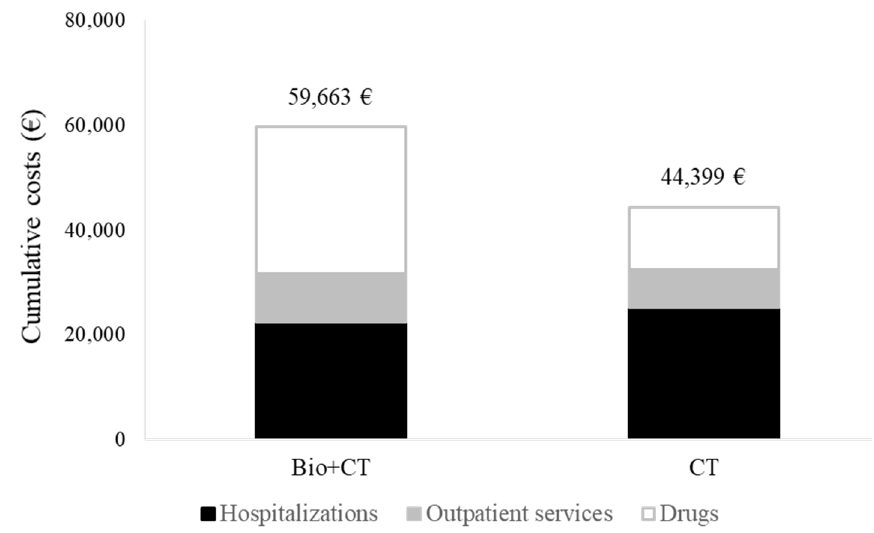
Figure 3. Comparison between cumulative per capita healthcare costs sustained by the NHS for caring for metastatic colorectal cancer cohort members on first-line treatment with biologic-based (bevacizumab or cetuximab, Bio + CT) or standard chemotherapy (CT) alone. FABIO project, Italy, 2010–2016.